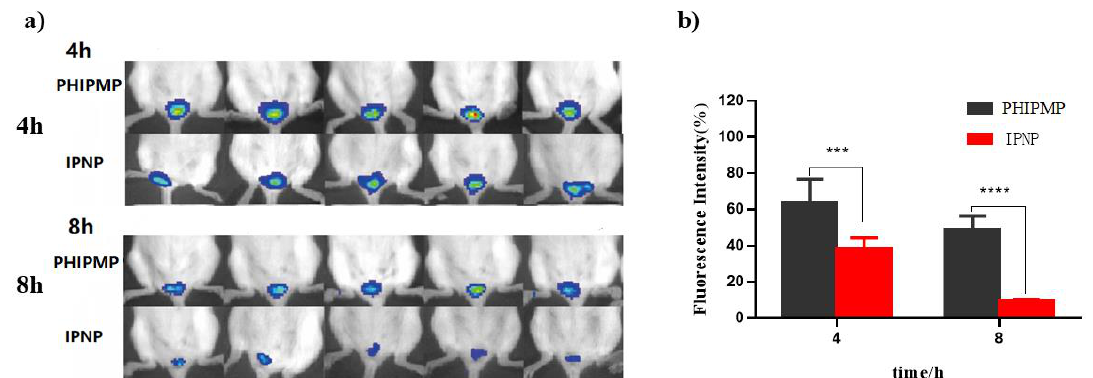
Figure 4. Intravaginal retention of DiR-labeled formulations 4 and 8 h after intravaginal administration. ( a ) Typical fluorescent images; ( b ) semiquantitative data of the fluorescence intensity ( n = 5), *** indicates p < 0.001, **** indicates p < 0.0001. (PHIPMP: PTX/HA-IMN/PLGA microparticles; IPNP: IMN/PLGA nanoparticles).